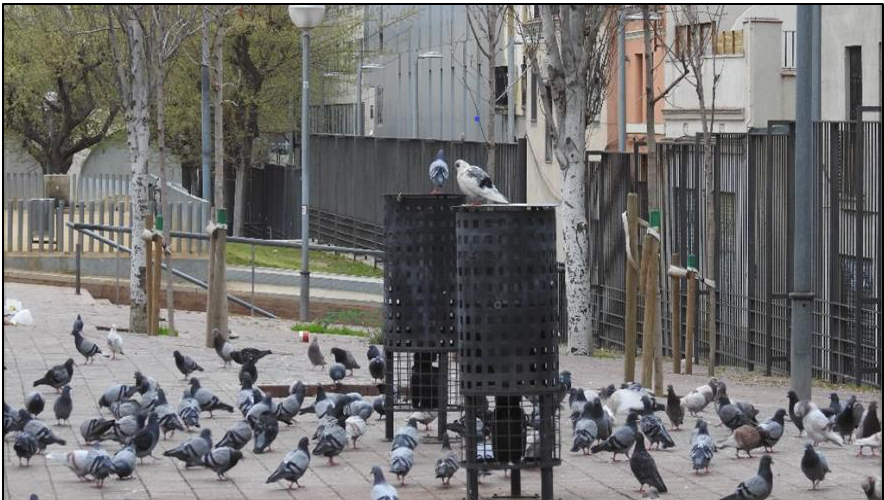
Figure 2. Automatic hopper feeders used for the administration of the